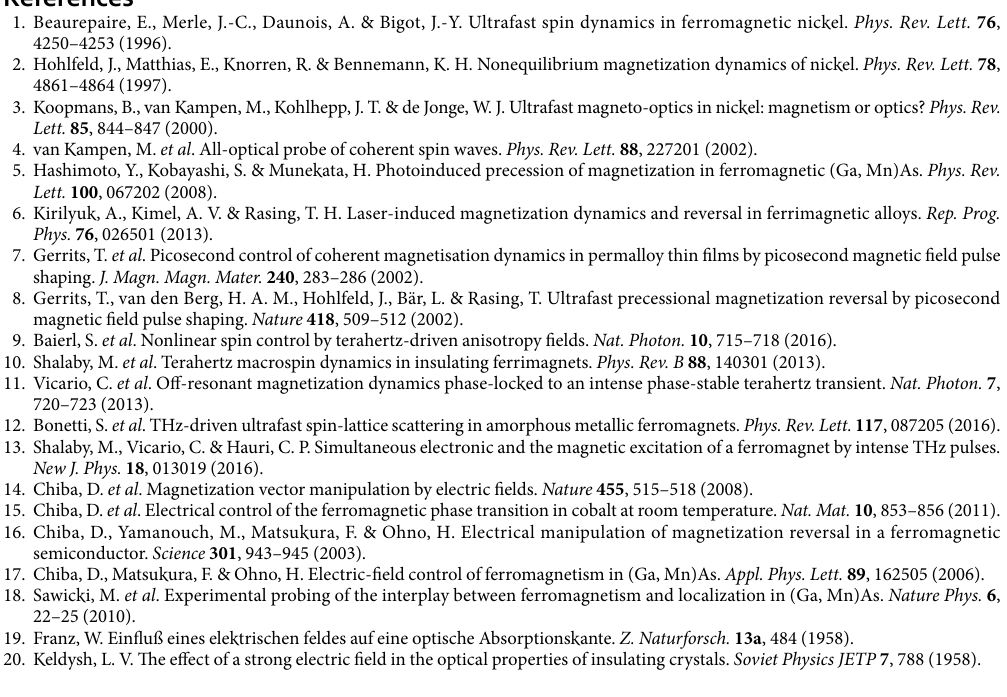
intensity was adjusted by rotating two wire-grid polarizers. The time duration of the probe pulse was 90 fs, and the wavelength was 800 nm. The delay time of the probe pulse relative to the pump pulse was controlled by changing the length of the optical path of the probe pulse. Δ θ was detected by a balanced detection technique using a half-wave plate, a polarizing beam splitter, a pair of balanced silicon photodiodes and a boxcar integrator. We defined the time origin ( t = 0 ps) of the terahertz pulse as the time when the terahertz electric field reaches a maximum. All measurements are carried out at 10 K.